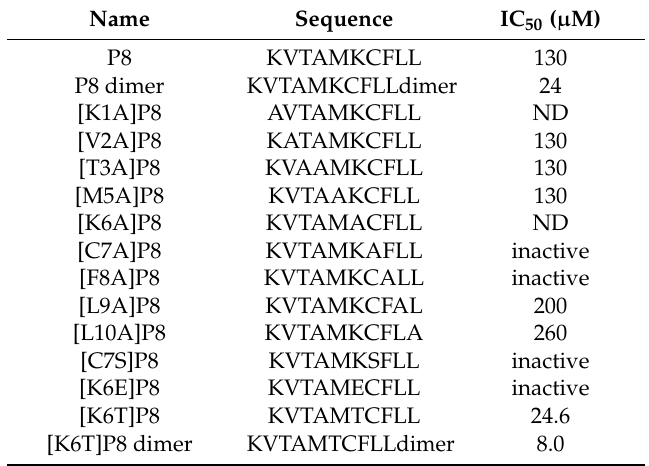
Table 5. Peptide sequences deriving from IL-15 36–45 fragment, P8, obtained by point mutations. IC 50 values were obtained in proliferation assay, ND: Not